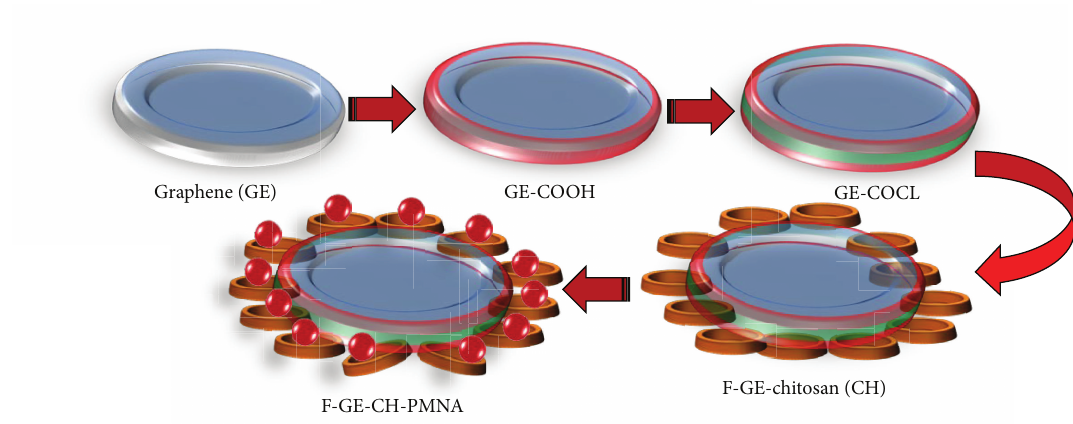
Figure 1: Reaction scheme used in the synthesis of GE-CH-PMNA.